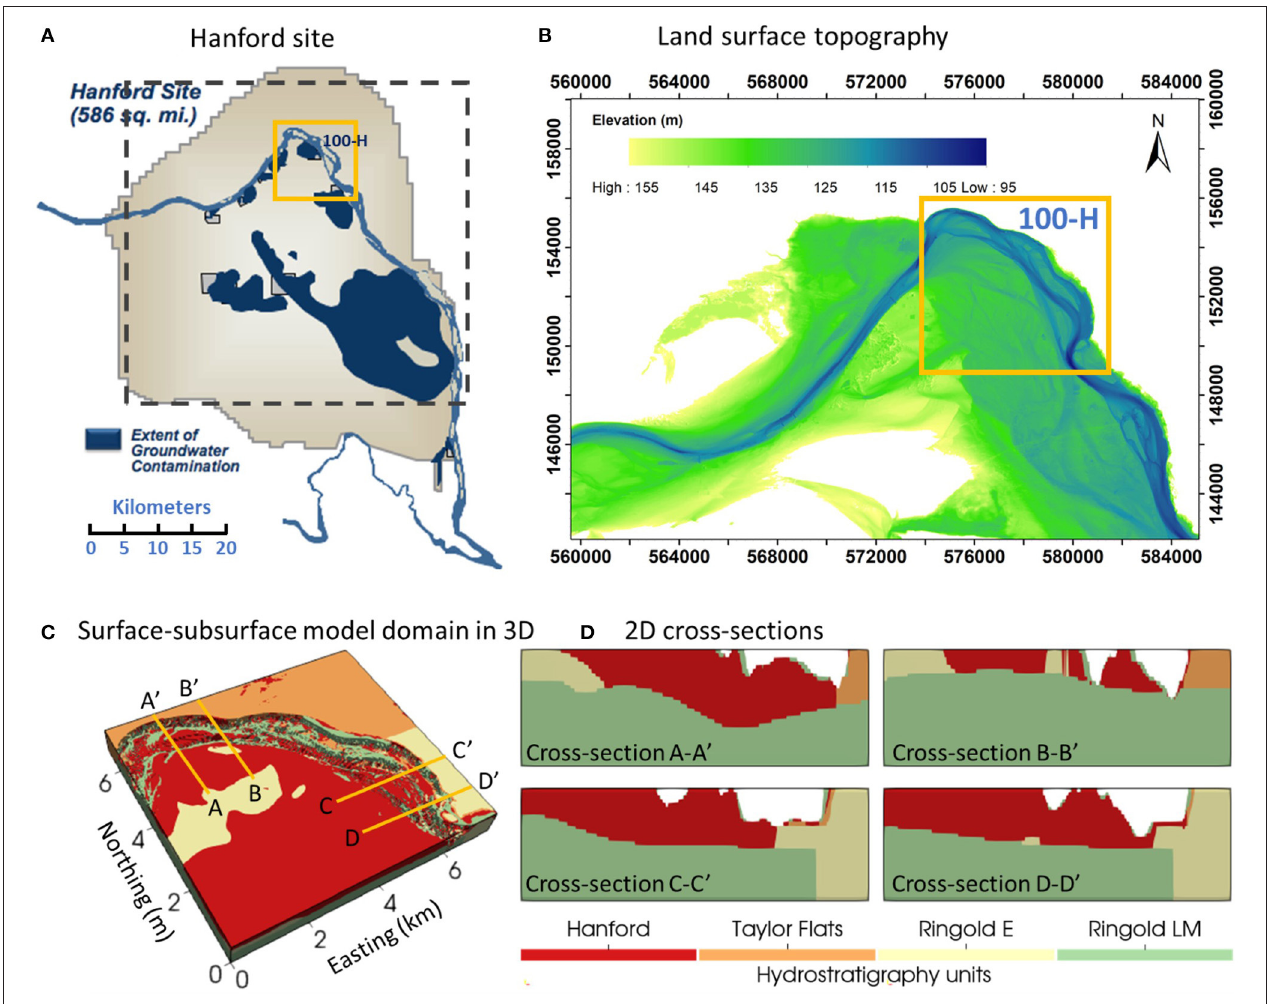
FIGURE 1 | (A) Map of Hanford site; (B) Land surface topography of the model domain; (C) 3D representation of the model domain with various geologic units; (D) 2D cross-sections of the model domain. Locations of the cross-sections in (D) are as indicated in (C) .